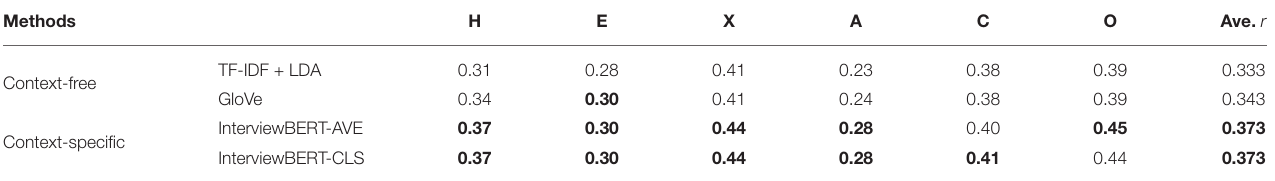
TABLE 2 | Correlation coefficient r of different methods which aggregate the scores after prediction. Methods